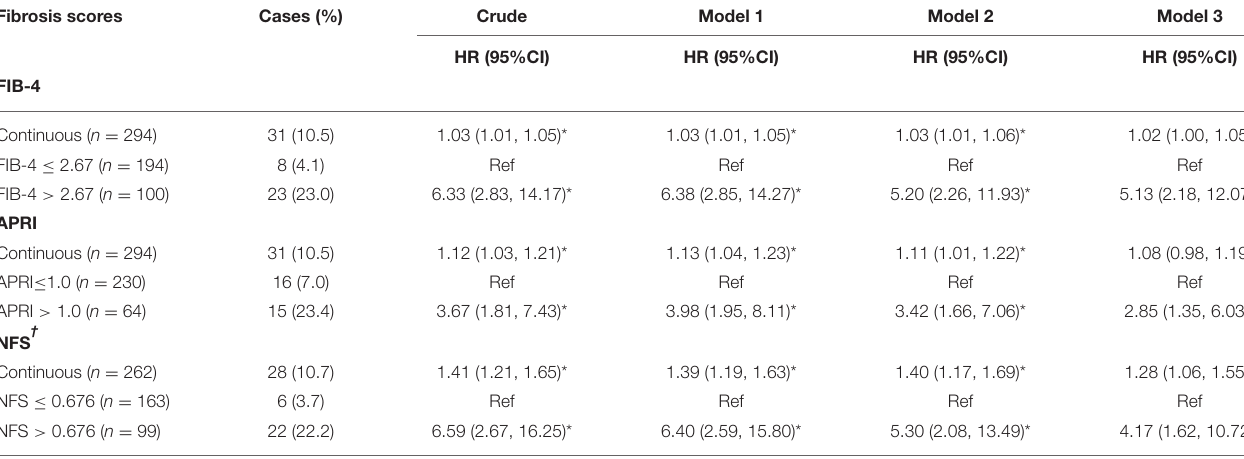
TABLE 3 | The association between Fibrosis scores and 28-days mortality in patients with COVID-19. Fibrosis scores Cases (%)